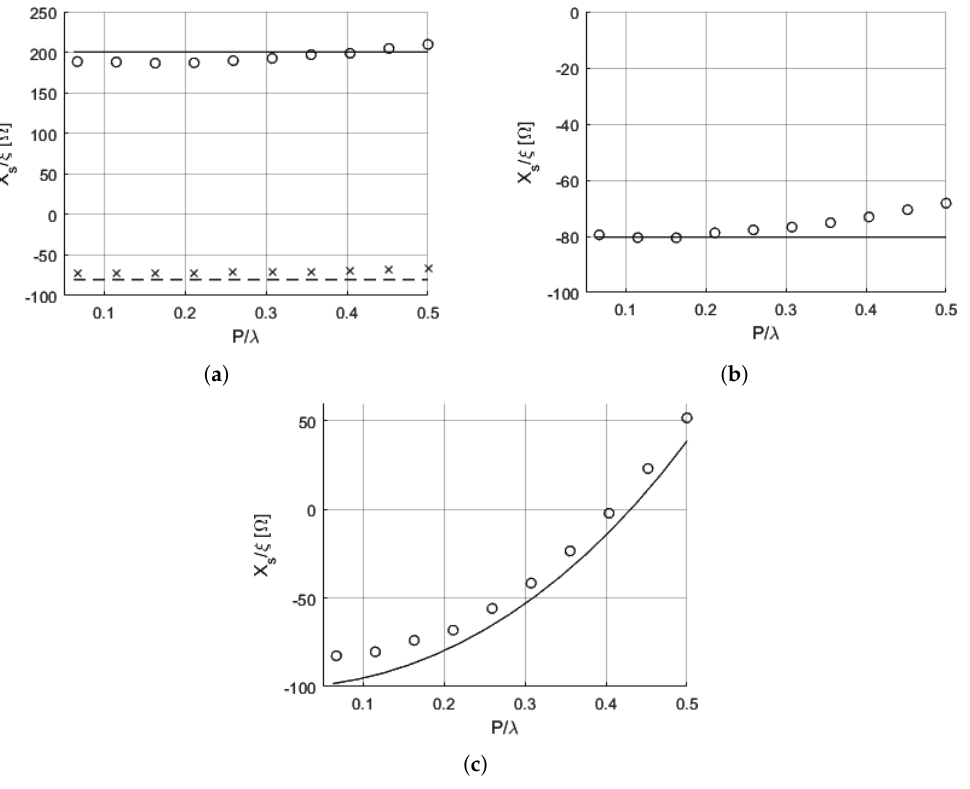
Figure 10. Performance of unit cells over the unit cell period. ( a ) Strips. Solid and circles—Inductive vertical strips, w = 4 P /10; dashed and crosses—capacitive horizontal strips, w = 8 P /10; ( b ) capacitive patches, w = 8 P /10; ( c ) predominantly capacitive loops, w = P /15, d = 8 P